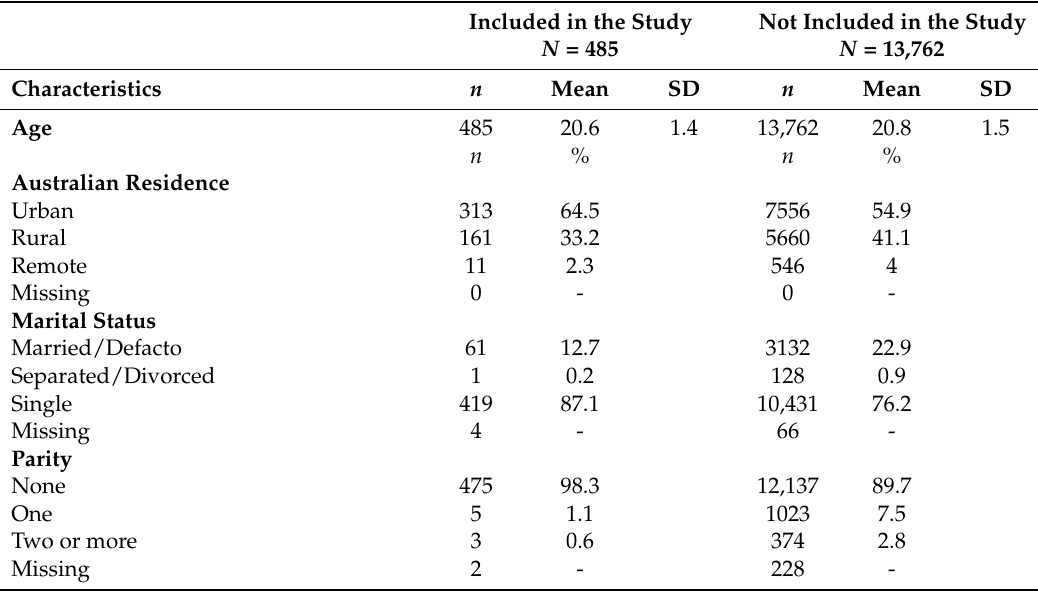
Table 1. Baseline characteristics † for the young cohort of the Australian Longitudinal Study